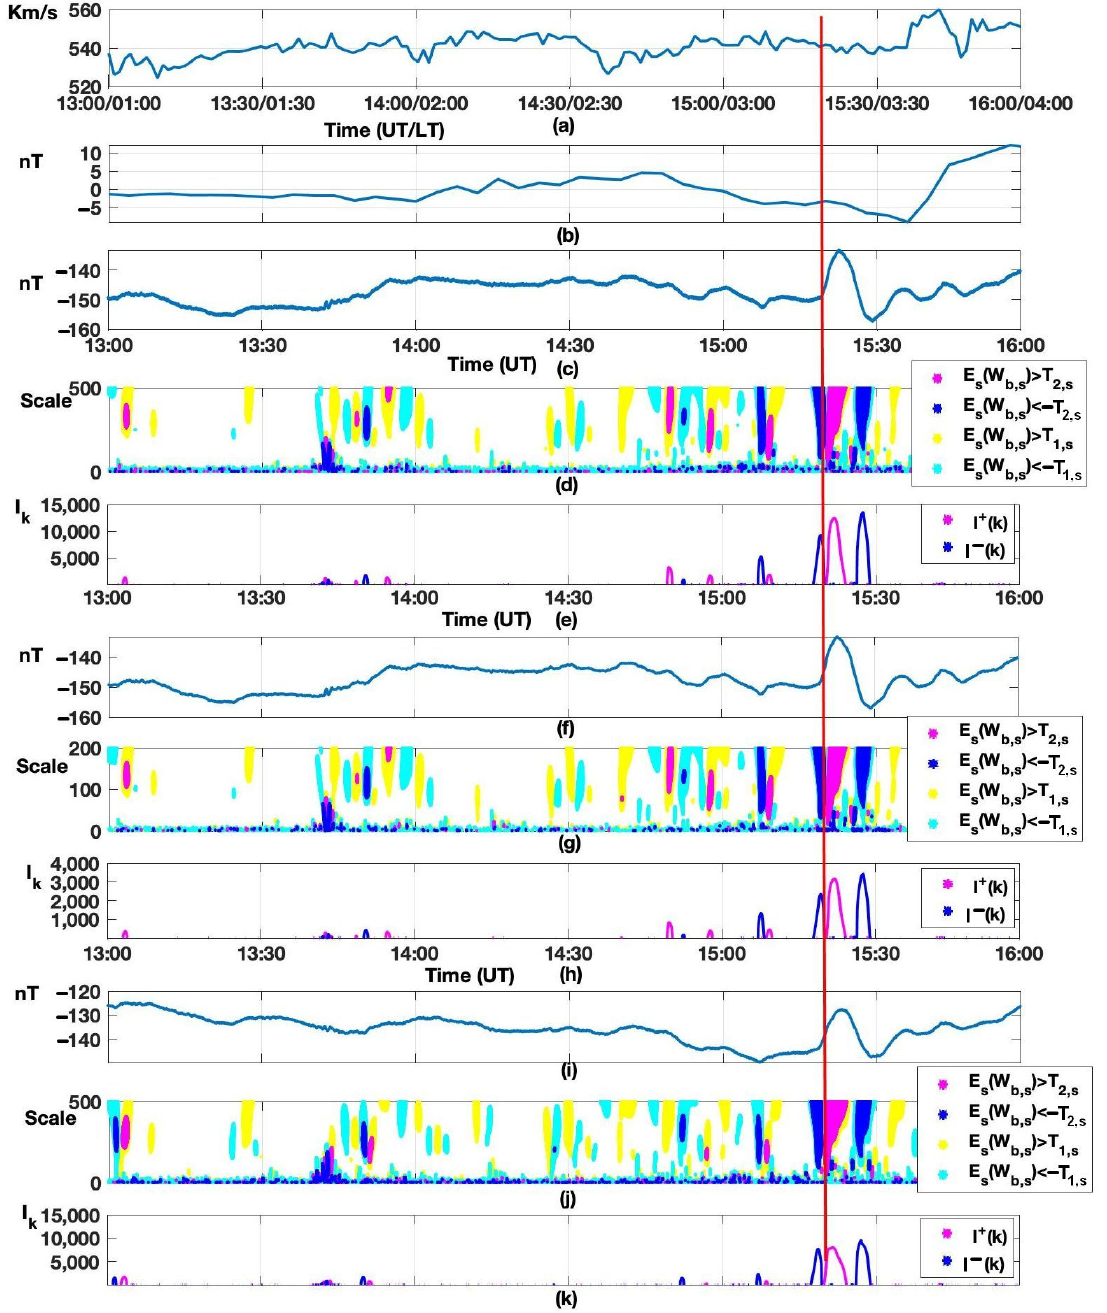
Figure 9. Processing results for geomagnetic data for the period 11–12 May 2021. ( a ) SWS; ( b ) IMF Bz (GSE); ( c ) DST; ( d ) H-component; ( e , f ) results of method application. The red vertical line is the magnetic storm